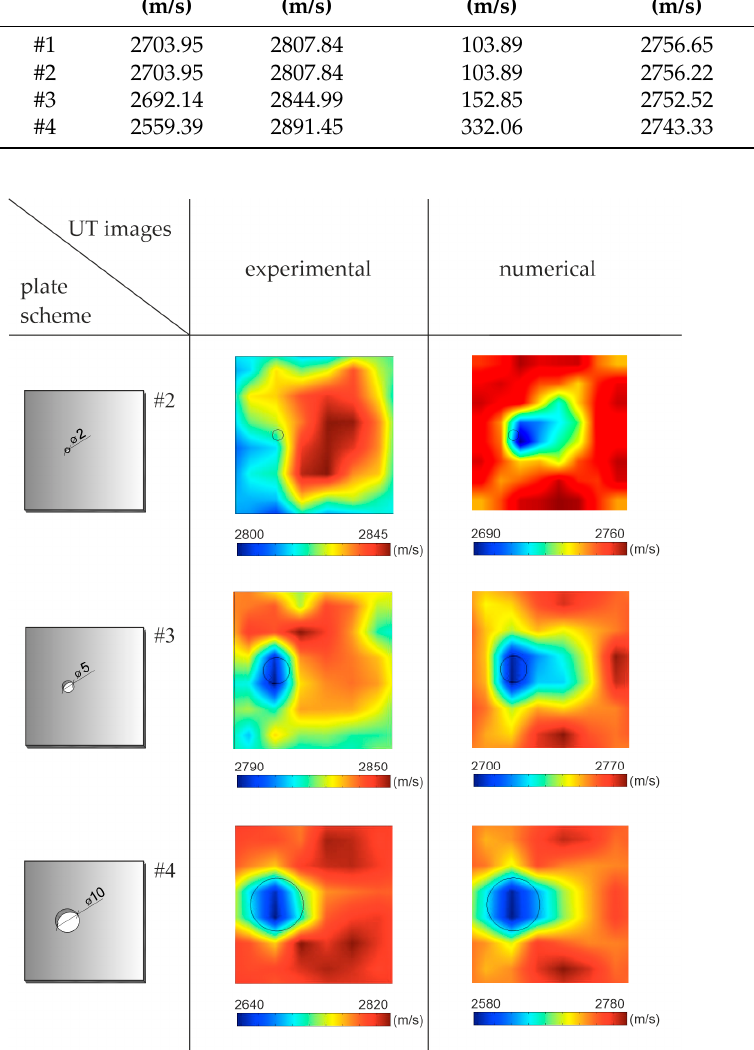
Figure 9. Ultrasonic tomography (UT) velocity maps using direct wave transition in plates with surface damage.